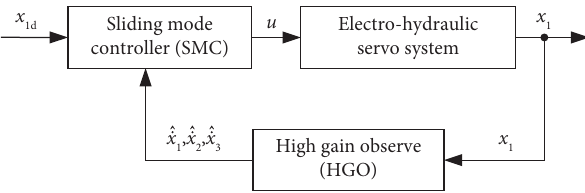
Figure 2: Block diagram of the presented SMC-HGO control scheme.